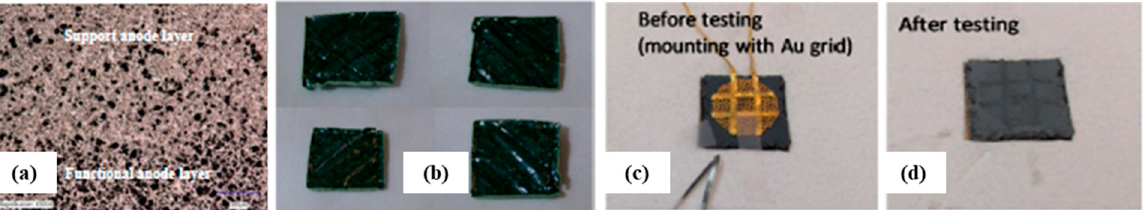
Figure 31. ( a ) Cross-section SEM image of the interface between the functional layer and support layer of an anode; ( b ) Ni-YSZ anode samples with the cell sample mounted on an Au grid for testing the I-V curve and EIS; ( c ) sample mounted on grid with Au before testing ( d ) cell sample after testing (Adapted from reference [191]).